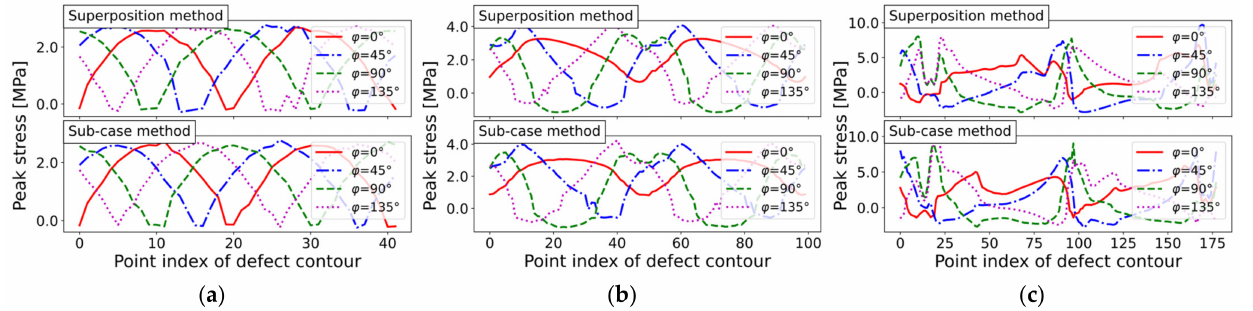
Figure 17. N-SIF peak stress course for three defect geometries assuming a blunt notch and incremen- tal load step of ∆ ϕ = 10 ◦ : ( a ) Circular hole-in-plate (mesh ‘circle_lin_R1mm_v1’); ( b ) Elliptical hole- in-plate (mesh ‘ellipsis_lin_rot0deg_v1’); and ( c ) Elongated defect (mesh